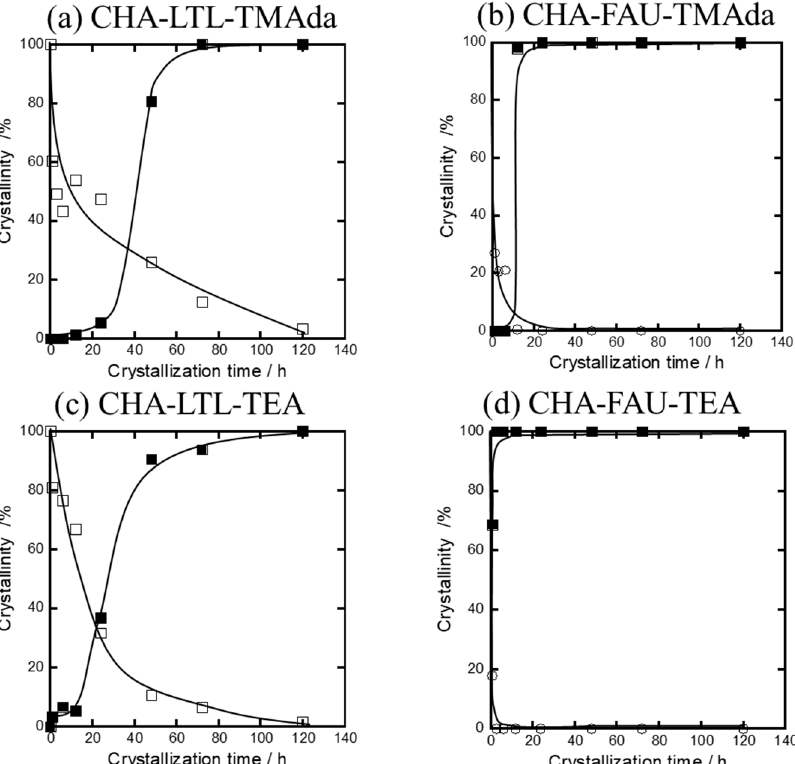
Figure 3. Relationship between crystallization time and crystallinity of LTL ( □ ), FAU ( ○ ) and CHA ( ■ ). ( a ) CHA–LTL–TMAda, ( b ) CHA–FAU–TMAda, ( c ) CHA–LTL–TEA, ( d ) CHA–FAU–TEA.